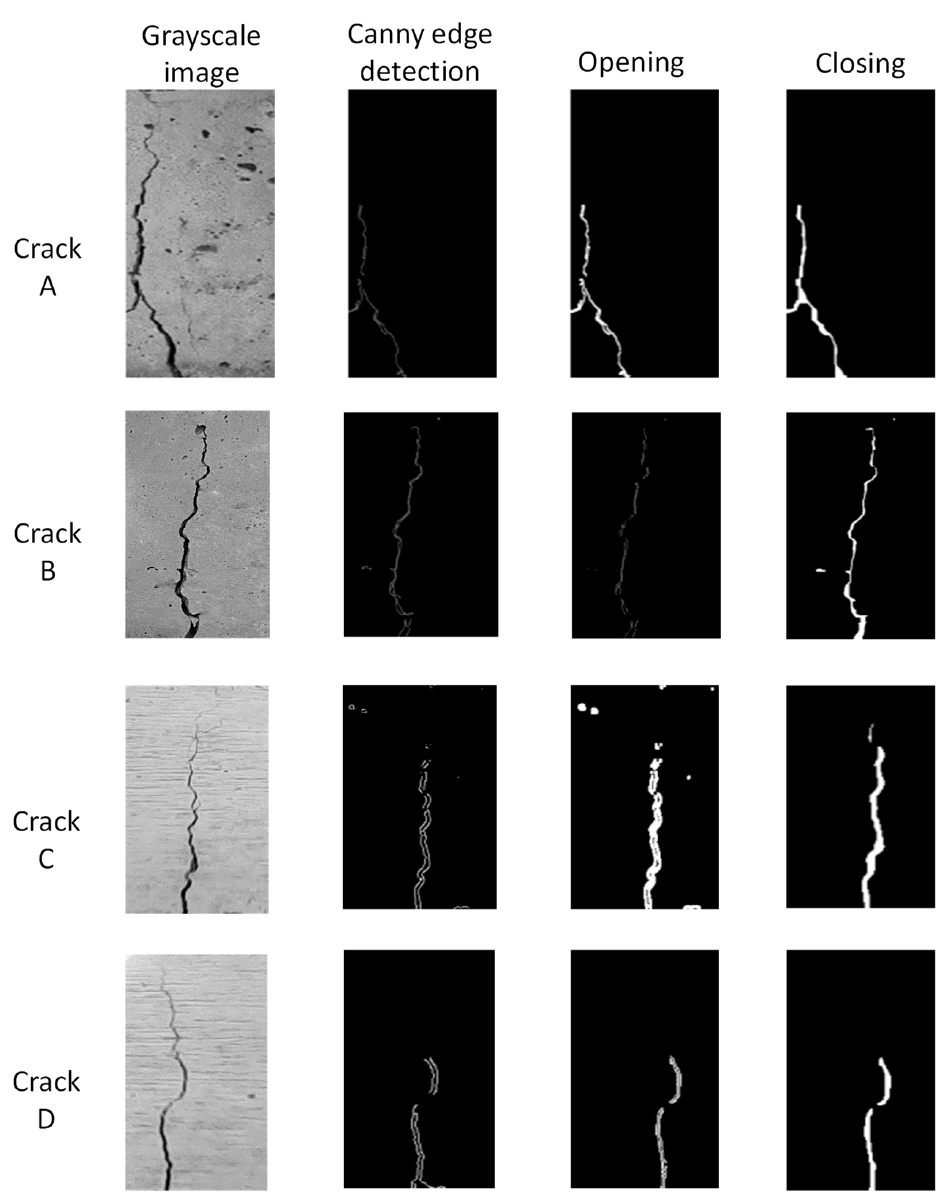
Figure 5. Segmentation of cracks using image processing algorithms.